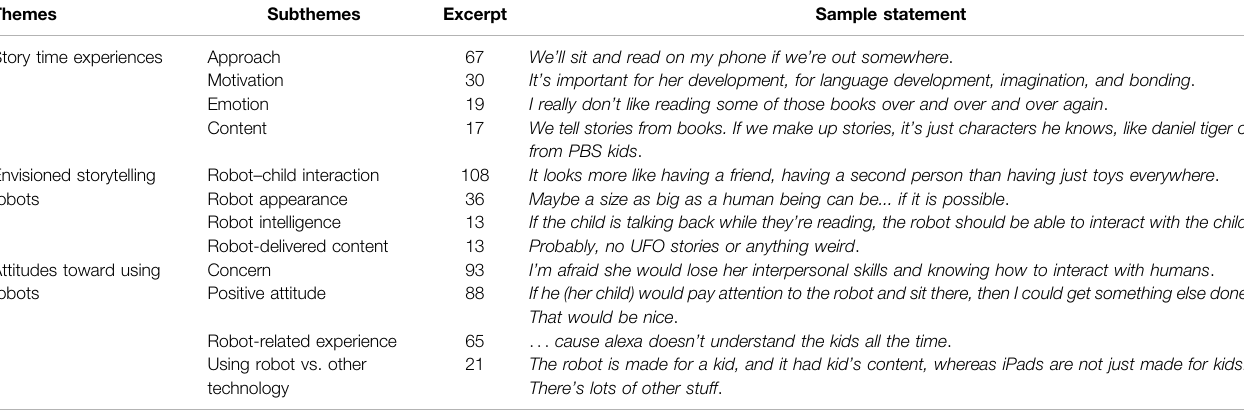
TABLE 1 | Data themes and